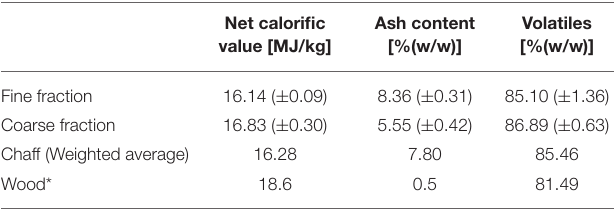
TABLE 2 | Determined parameters on a dry basis (averaged value with standard deviation).